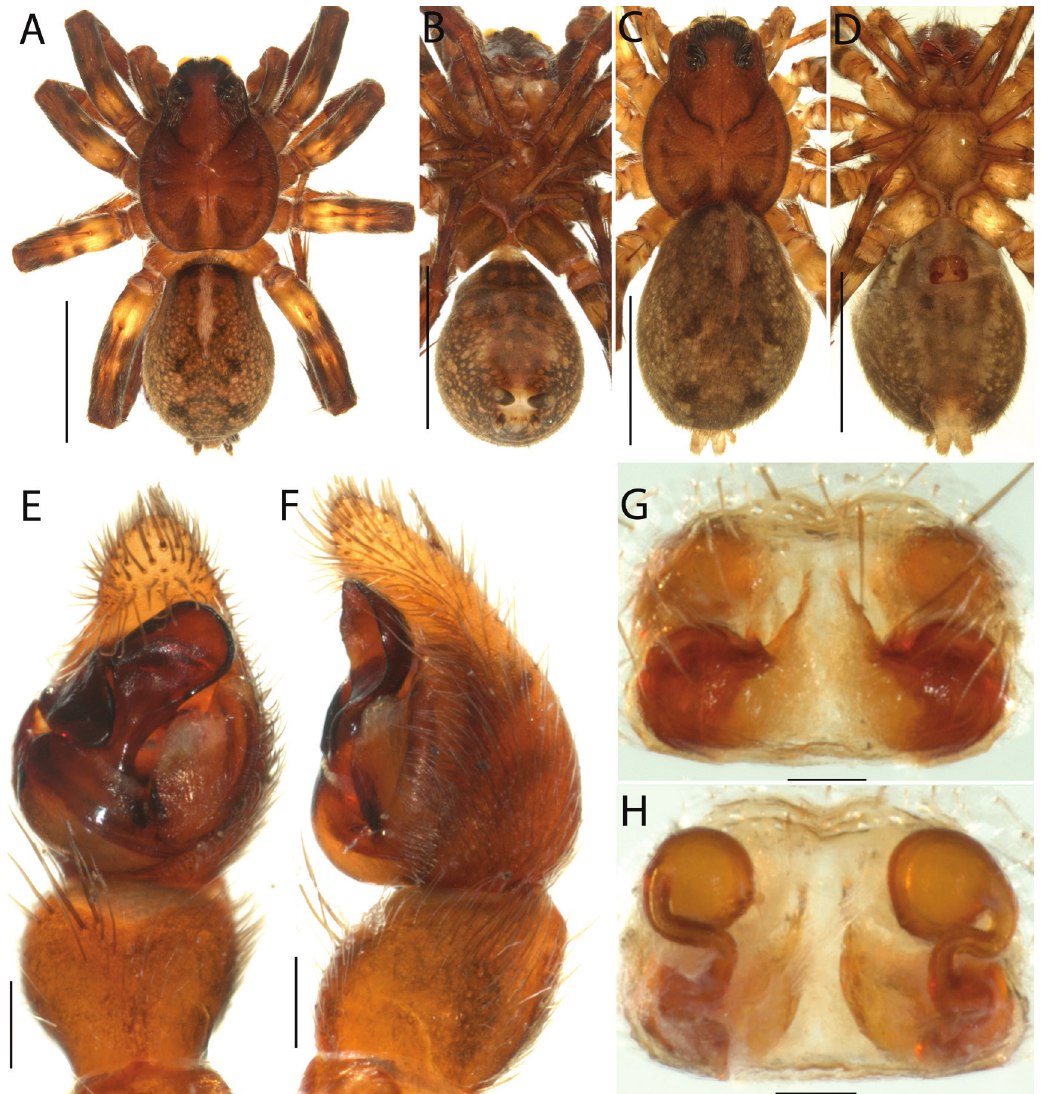
Figure 42. Artoria ulrichi Framenau, 2002, male and female (AM KS4316): A , male habitus, dorsal view; B , male habitus, ventral view; C , female habitus, dorsal view; D , female habitus, ventral view; E, male pedipalp, ventral view; F , male pedipalp, retrolateral view; G , epigyne, ventral view; H , epigyne, dorsal view. Scale bars: habitus 1.0 mm; pedipalp, epigyne 0.1